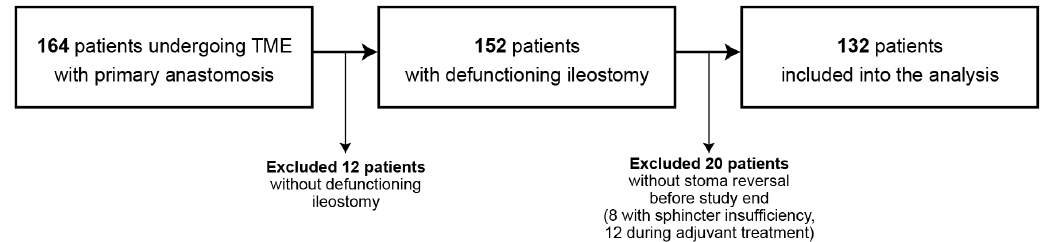
Figure 1. Flowchart of patients included in study with reasons for exclusion from the analysis. TME: total mesorectal excision.